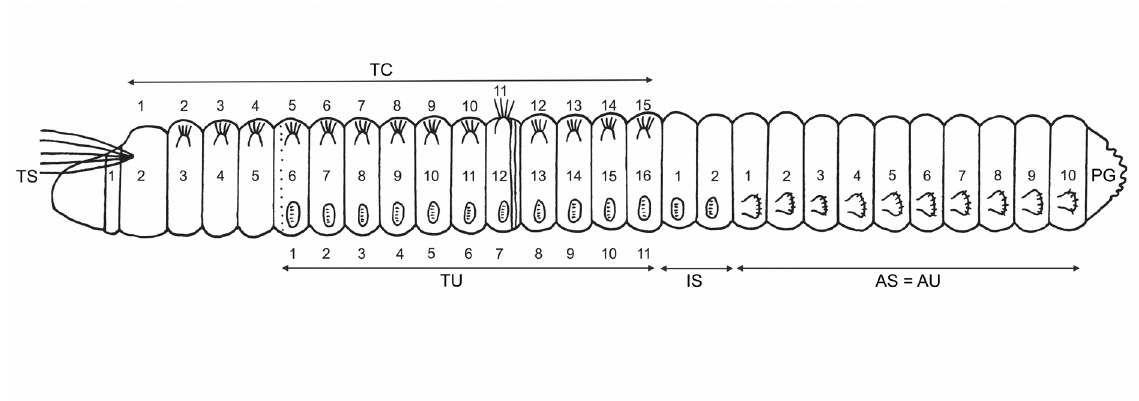
Fig. 1. Schematic lateral view of Anobothrus konstantini Säring & Bick sp. nov. Abbreviations: see Material and methods. Vertical dotted line in TS6 represents circular glandular band. Vertical lines in TS12 represent elongated ridge between